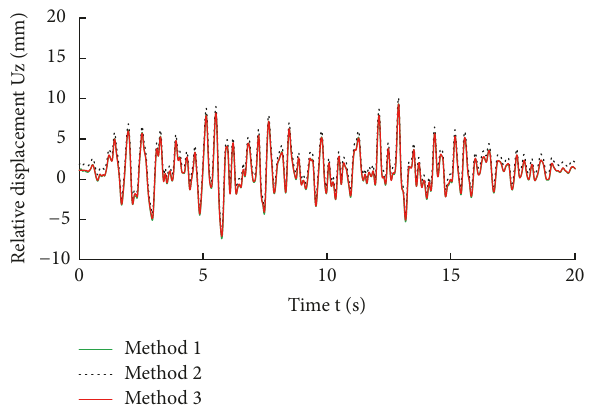
Figure 21: Time history curve of the Z component relative displace- ment at the top of dam.